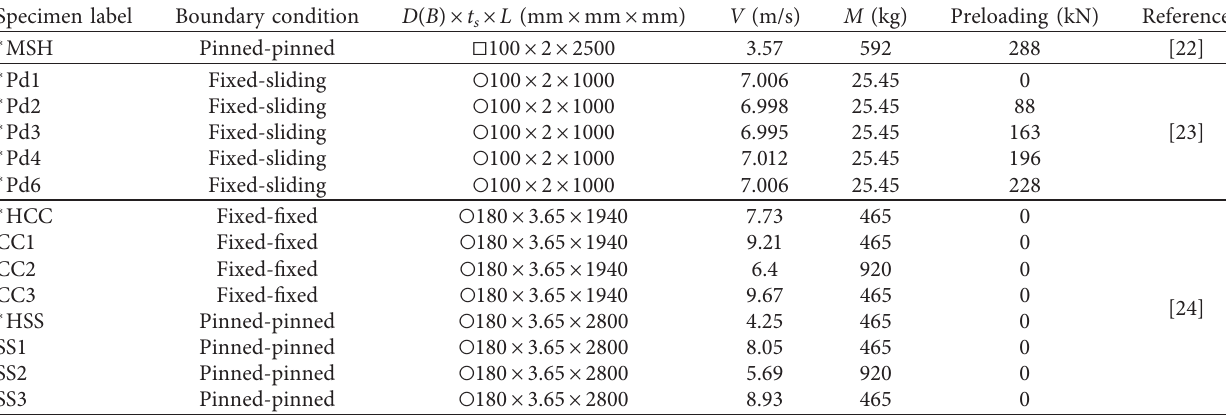
Table 1: Detail information of the testing